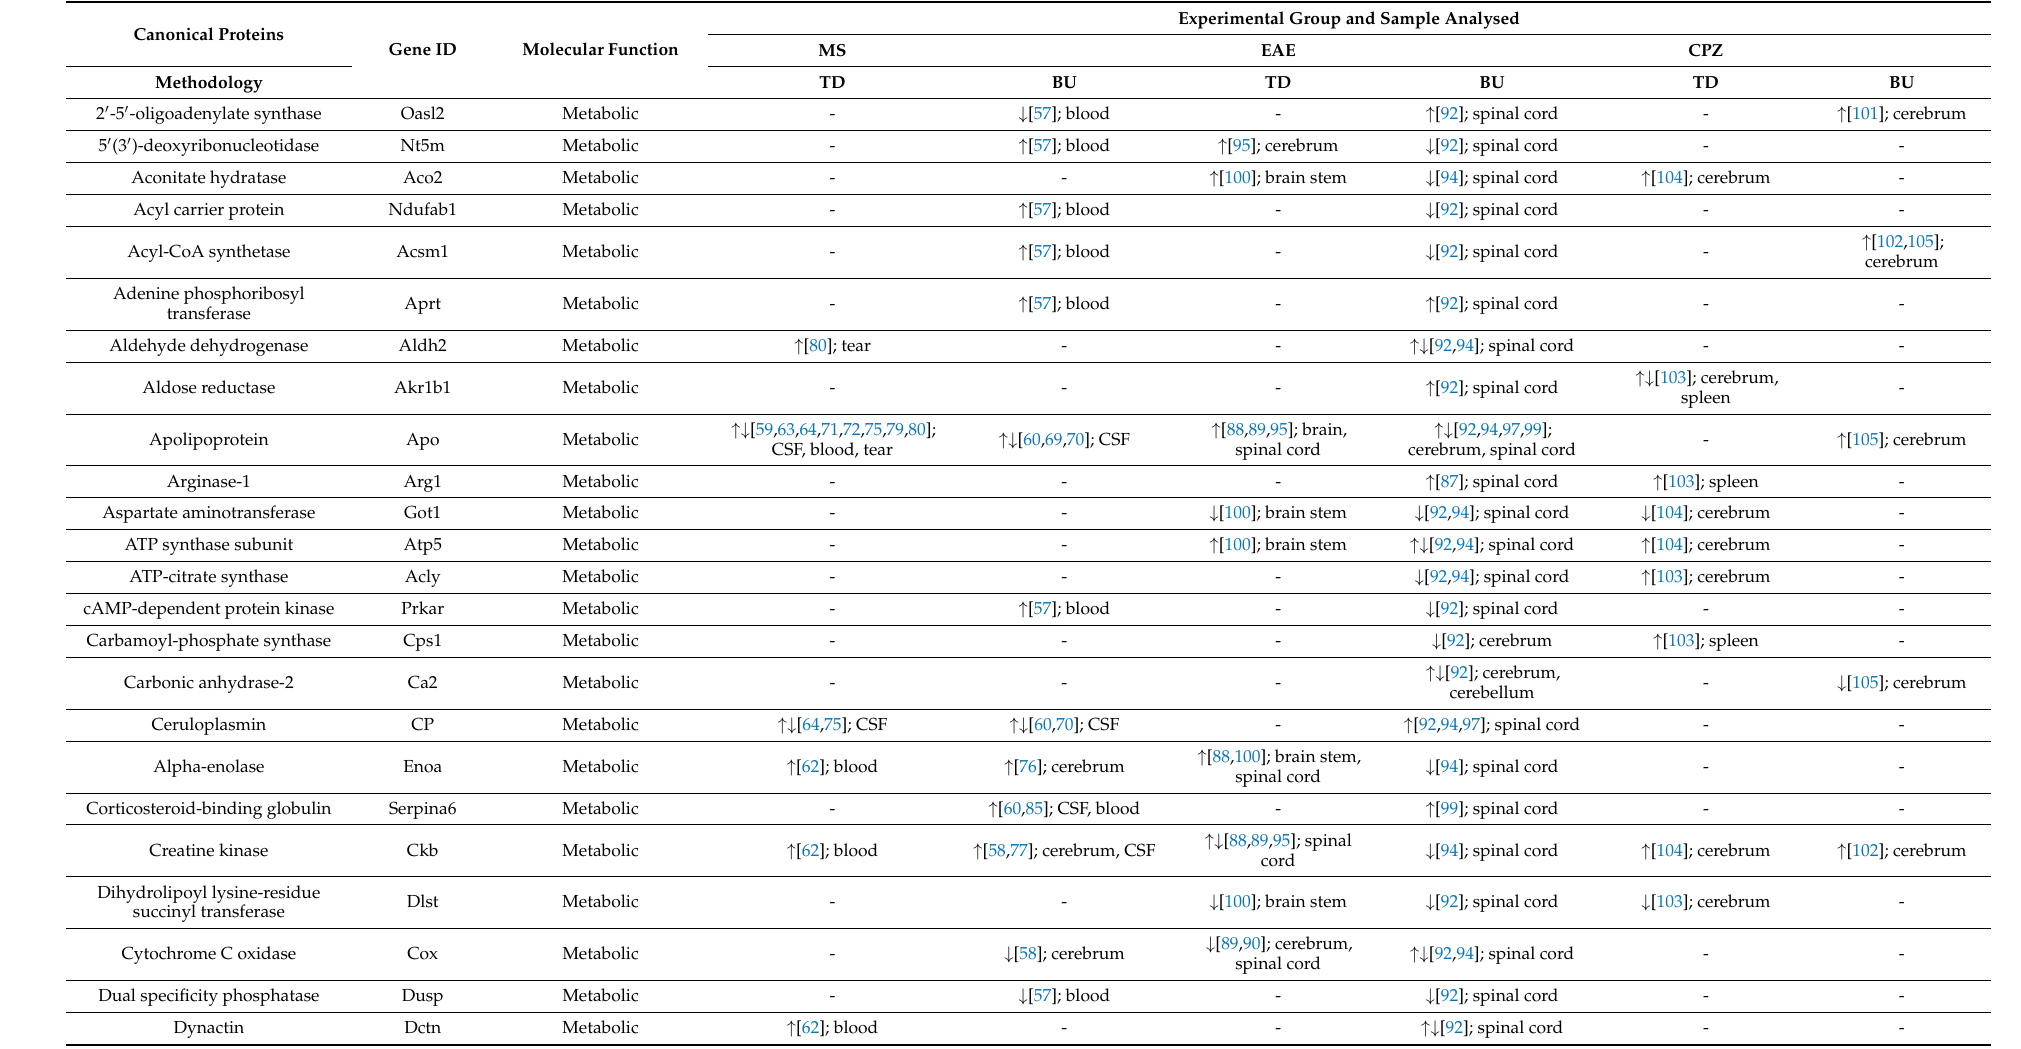
Table 3. Canonical proteins identified in MS, EAE, and